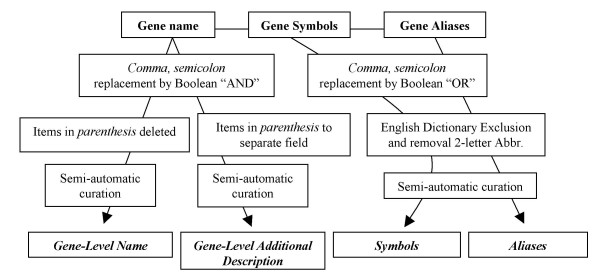
Flow diagram of the processing and curation of the gene names, symbols and aliases. Gene names, symbols and aliases were retrieved from Affymetrix HG_U95 / HG_U133 and the HUGO databases.